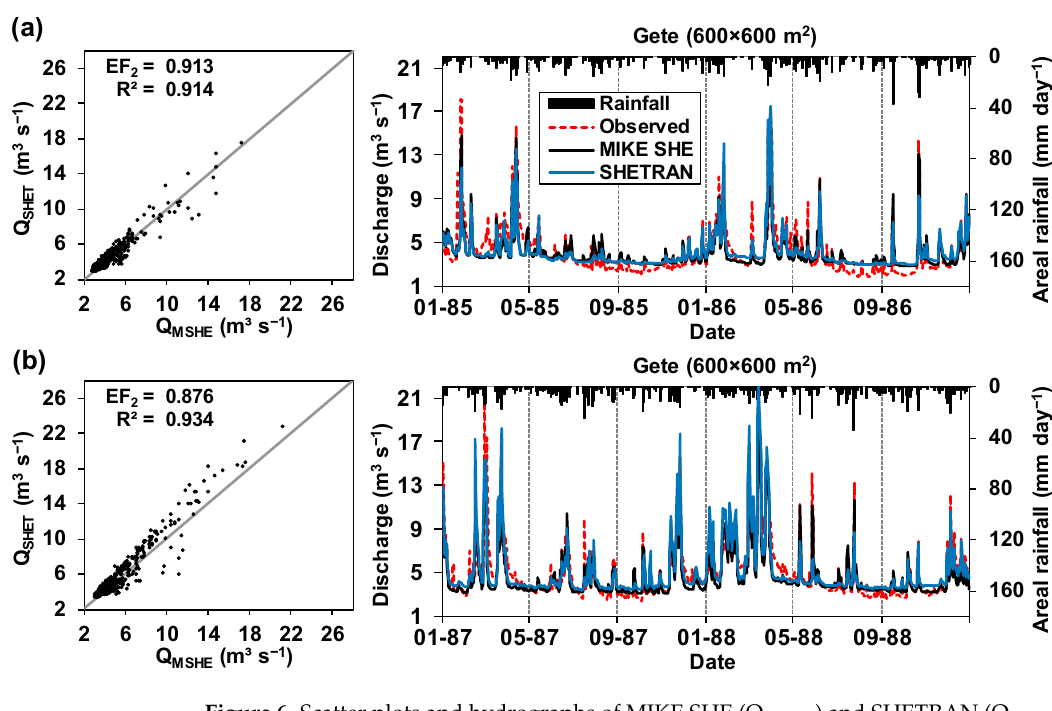
Figure 6. Scatter plots and hydrographs of MIKE SHE (Q MSHE ) and SHETRAN (Q SHET ) total stream- flow simulations at the outlet of the catchment for ( a ) the calibration period [1 January 1985–31 December 1986]; and ( b ) the validation period [1 January 1987–31 December 1988]. EF 2 = Coefficient of Efficiency (Nash and Sutcliffe Efficiency); R 2 = square of the Pearson’s type (linear) correlation coefficient.